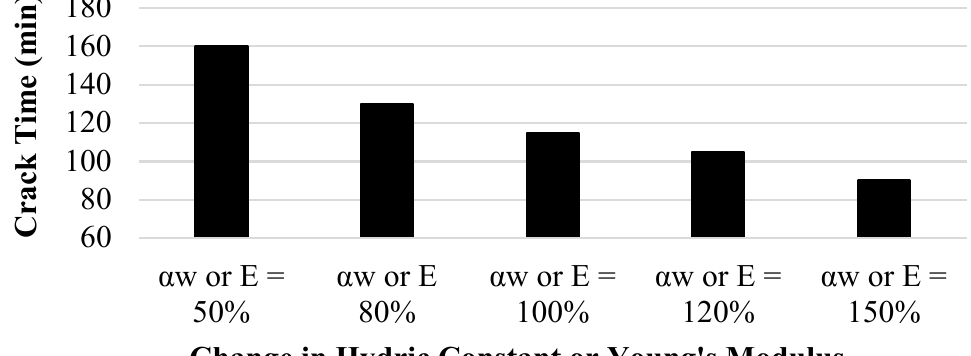
Figure 19. Hydric constant sensitivity analysis on crack initiation time.